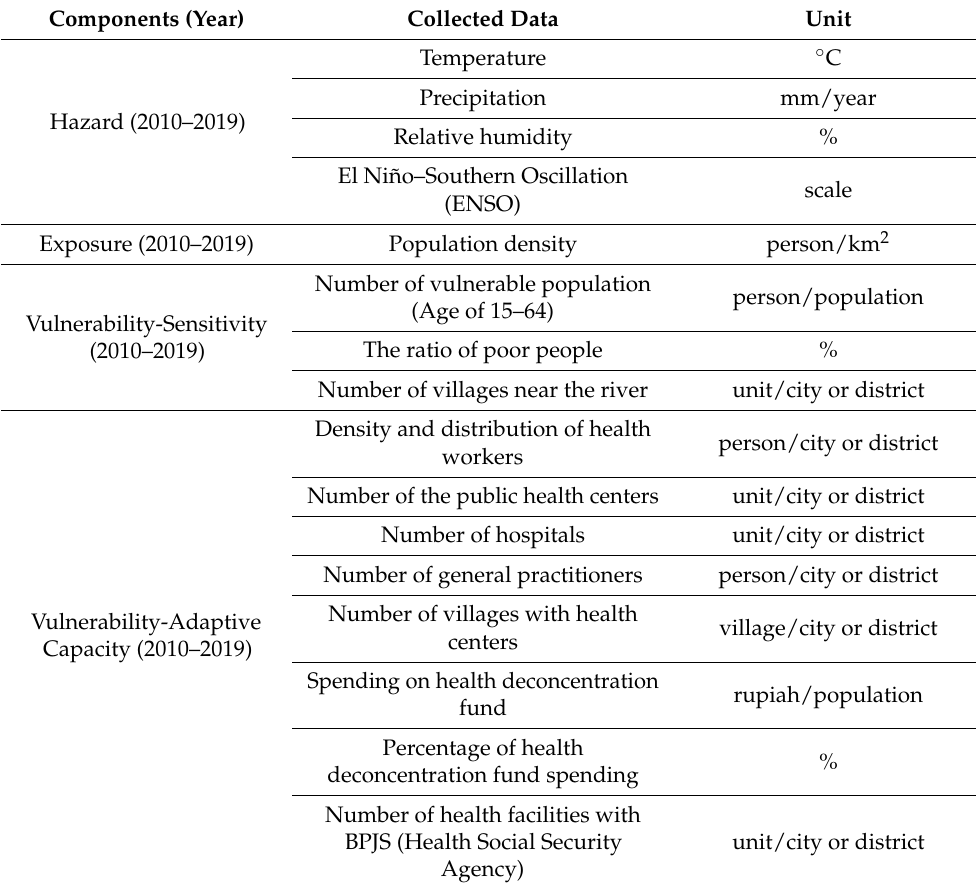
Table 1. Components of data